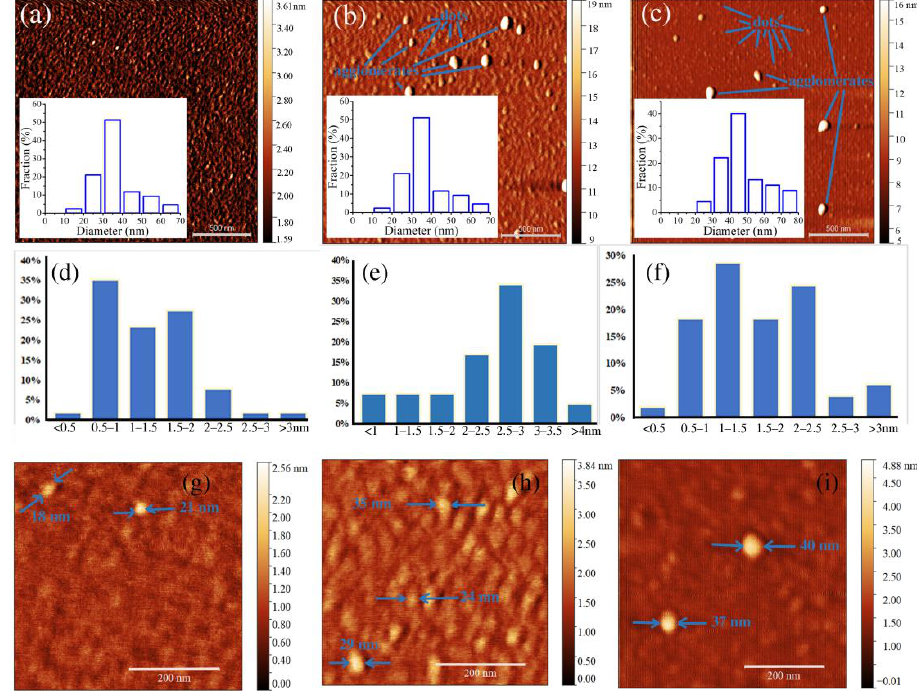
Figure 1. AFM images of GQD-EDA/1 g ( a ), GD-EDA/5 g ( b ), and GQD-EDA/10 g ( c ), with height distributions ( d – f ) and large-scale AFM images of isolated dots ( g – i ), respectively. The size distribution of GQDs was investigated using DLS and their surface charge was measured by zeta-potential ( ζ ). The results of DLS and ζ -potential are reported in Figure 2a,b, respectively. All the measured GQDs show a monomodal number-weighted diameter distribution with mode values of 33.4 nm (GQD-EDA/10 g), 42.0 nm (GQDs- EDA/5 g), and 55.7 nm (GQDs-EDA/1 g). The ξ -potential plots are presented in Figure 2b and show that all investigated samples display values in the negative electric region. The following values obtained for GQDs-EDA/1 g, GQDs-EDA/5 g, and GQDs-EDA/10 g were − 28.0 ± 1.6 mV, − 32.8 ± 1.4, and − 25.9 ± 0.9 mV, respectively. An increase of ξ -potential values of irradiated GQDs compared with p-GQDs ( − 34 eV) [35] was due to a change in the amount of negatively charged functional groups during gamma irradiation in the presence of EDA, probably due to the lower number of carboxyl functional